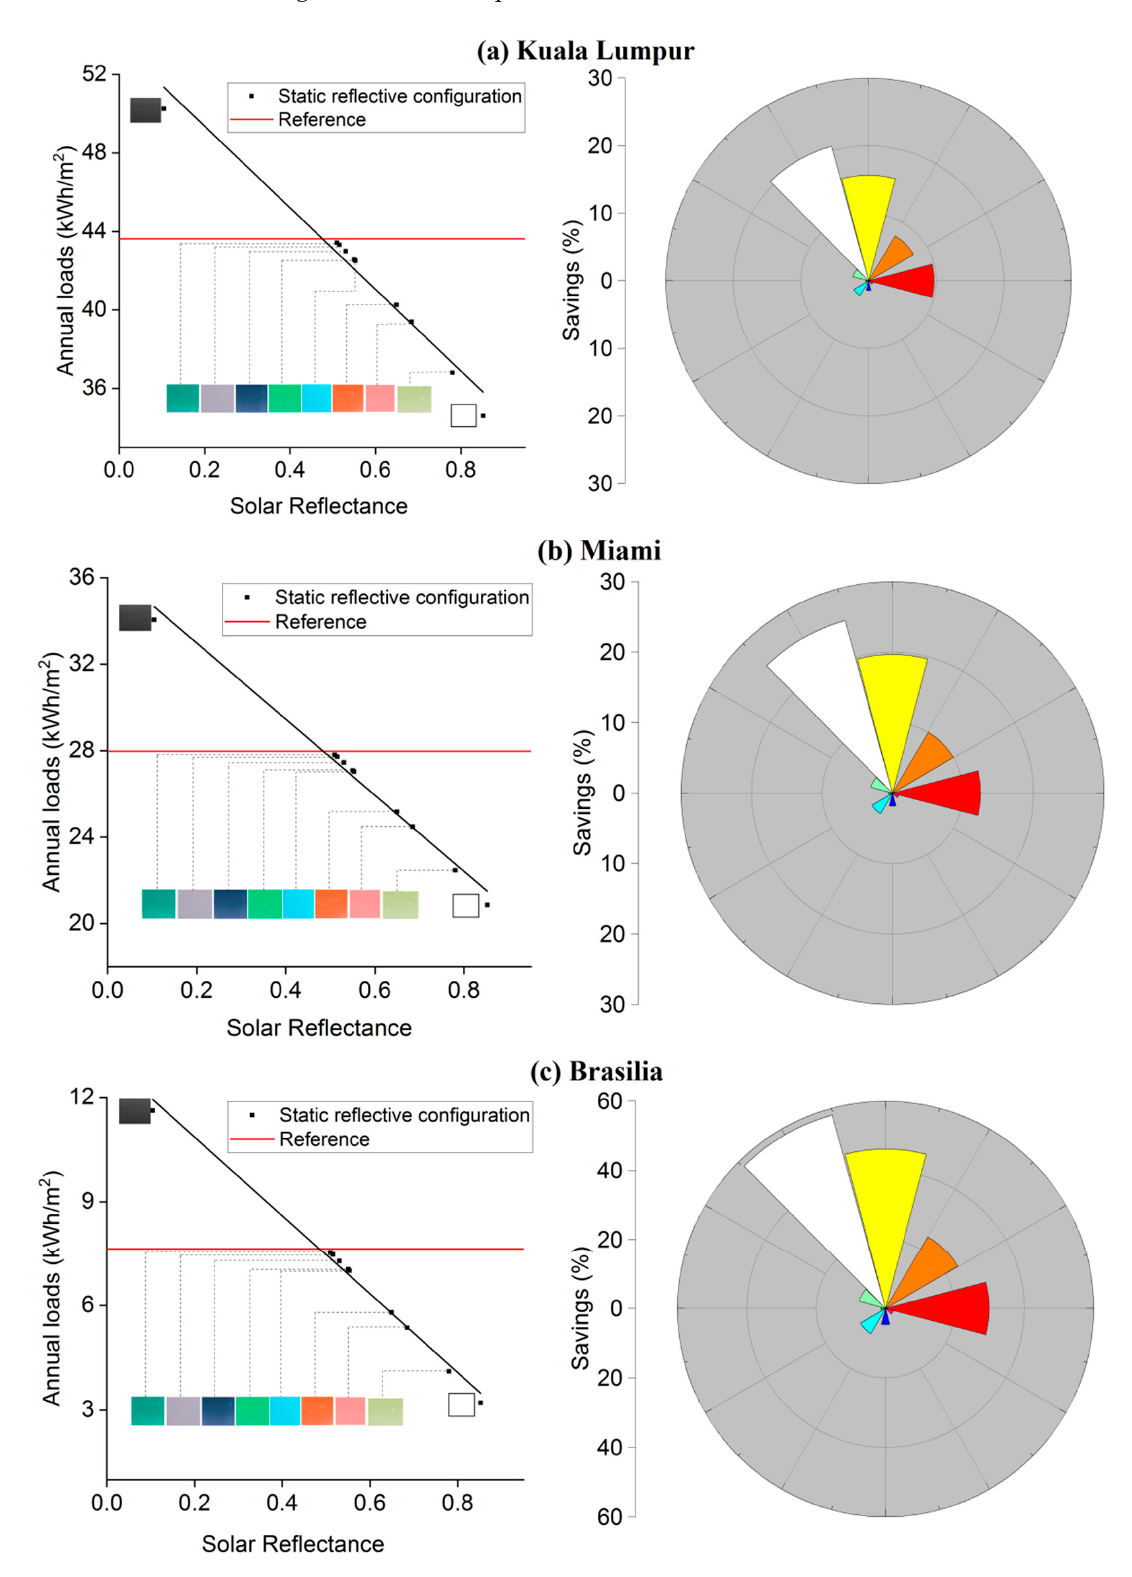
Figure 4. HVAC load savings in climate A (Tropical): ( a ) Kuala Lumpur, ( b ) Miami, ( c ) Brasilia. Figure 5 comprises the results obtained for climate B (Arid) locations. Four di ff erent subcategories can be found in this climate type termed S (steppe), W (desert), h (hot) and k (cold). Tenerife (Subcategory BSh) and Arequipa (Subcategory BWk) represent the two extreme cases within climate B type. In the fi rst case, high irradiances along the year prevent the need for heating loads, while in the la tt er, colder temperatures during the year prevent the need for cooling loads. In these cases, only the static con fi guration (re fl ective con fi guration in Tenerife and absorbent con fi guration in Arequipa) was applied. Results in Tenerife are very similar to those obtained in climate A, where just